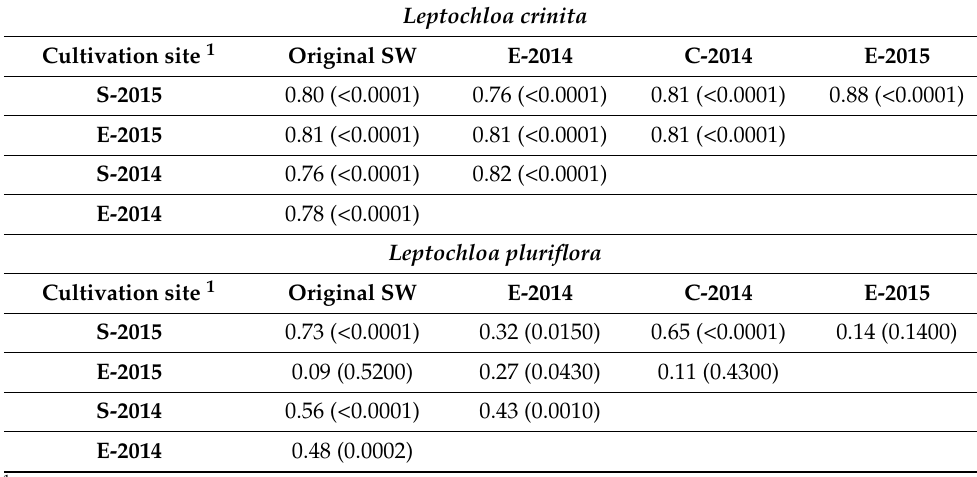
Table 1. Pearson’s correlation coefficients (r) for seed weight (SW) of populations of Leptochloa crinita and L. pluriflora harvested from two cultivation sites in two consecutive years. Probability values ( p -values) are shown in parentheses.